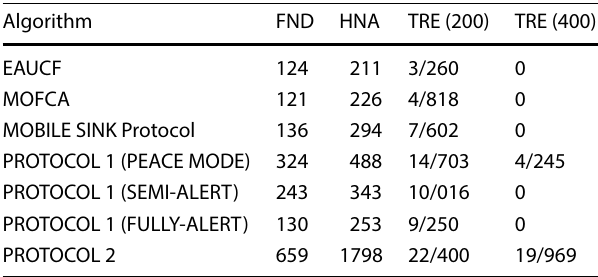
Table 5 Simulation results in scenario 4